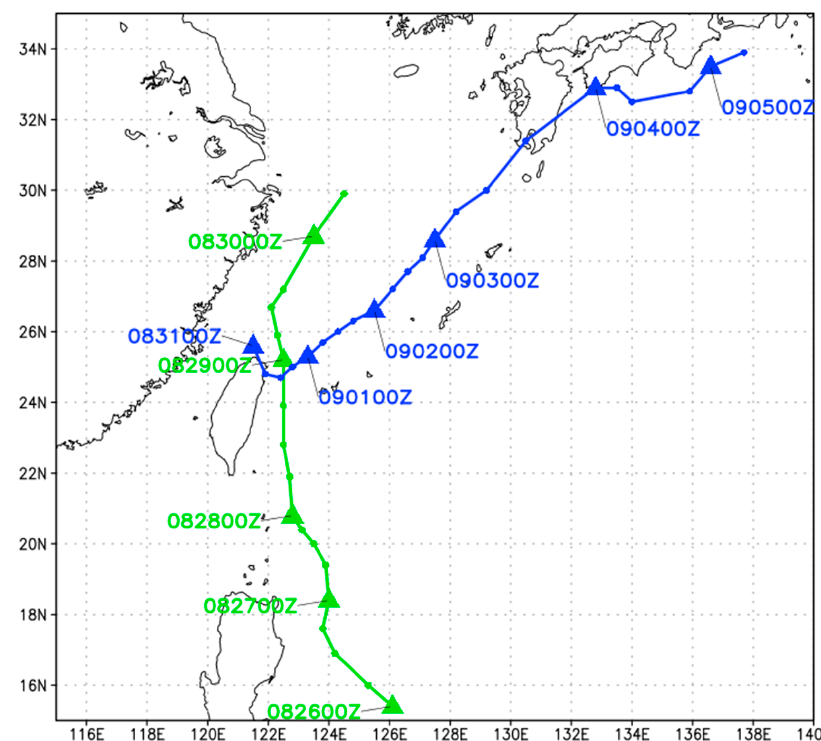
Figure 2. JMA Best Track of Kong-Rey (green curve) and Toraji (blue curve). After Kong-Rey approached the east coast of Taiwan, steered by the western part of a preexisting subtropical high-pressure extending over the western Pacific to Central China, vertical wind shear became stronger in this area due to the breakdown of the subtropical high-pressure ridge. On 29 August, the west edge of the subtropical high extended to Taiwan, causing the 500 hPa vortex to keep moving to the Taiwan Strait (Figure 3e). However, the low-level circulation center was still on the northeast of the island (Figure 3a), implying a decoupling structure of